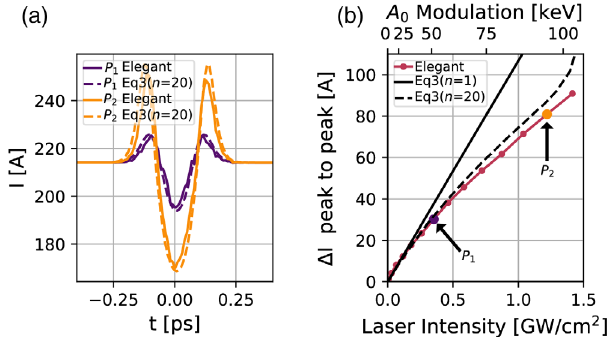
FIG. 3. Magnitude of the bunching factor for a train of Gaussian laser heater pulses as a function of pulse spacing. Dashed lines are from Eq. (4), while solid lines are from a numerical integration of the Vlasov equation, taking into account cross talk between neighboring